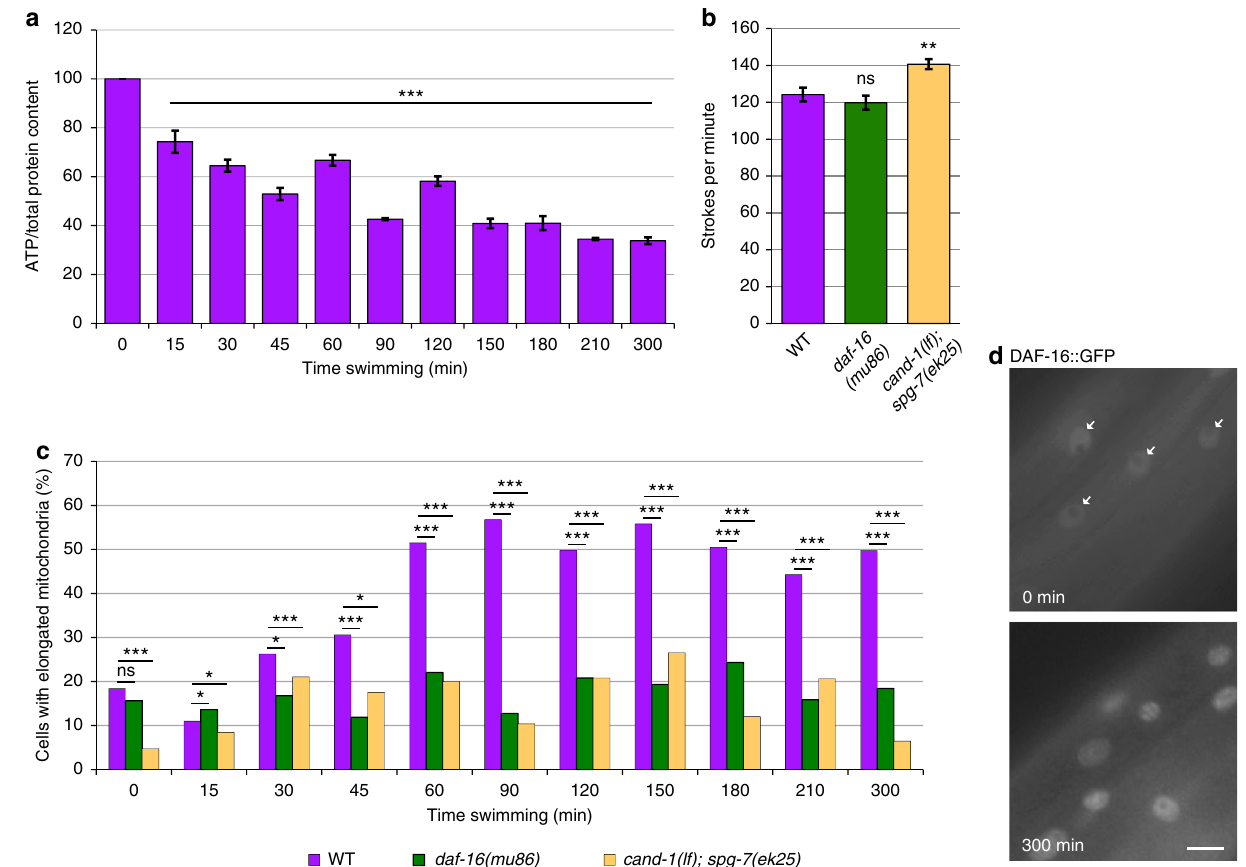
Fig. 5 DAF-16 is required for physical exertion-induced mitochondrial fusion. a ATP levels decrease during swimming. Graph of ATP levels (normalized to whole-animal protein levels) at the indicated times of continuous swimming. Error bars denote s.e.m. from two biological replicates, each with